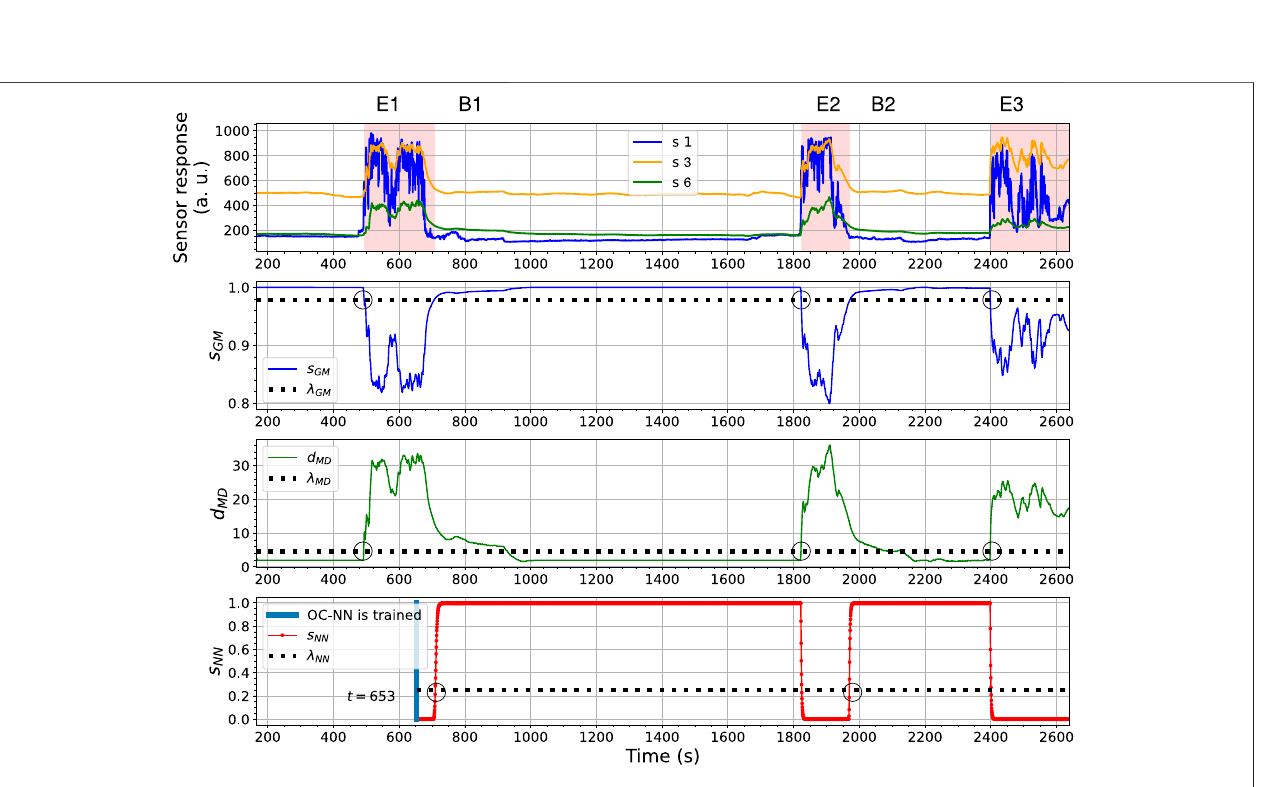
Frontiers in Chemistry |